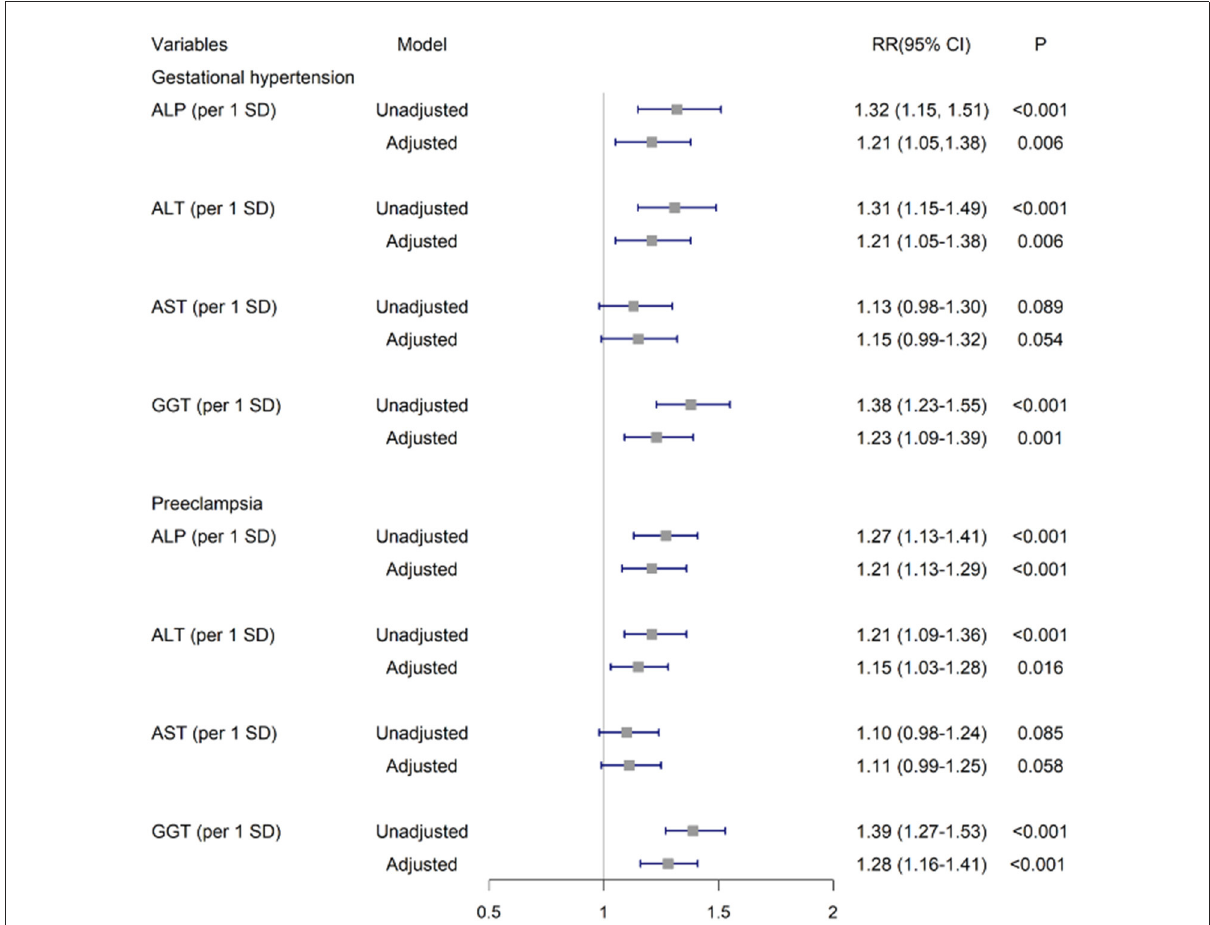
FIGURE2 Associations of ALP, ALT, AST and GGT in early pregnancy with GH and PE. The risk ratios and 95% CIs were estimated by multivariable log-binomial regression adjusting for age (years), preconception-BMI (normal: BMI < 24 kg/m 2 or overweight/obese: BMI ≥ 24 kg/m 2 ), supplementation of folic acid before pregnancy (yes/no), smoking exposure during gestation (yes/no), whether gravidity > 1 (yes/no), gestational week and fasting glucose at the 1 st antenatal visit. GH, Gestational hypertension; PE, Preeclampsia; GGT, γ -glutamyl transferase; ALT, alanine aminotransferase; ALP, alkaline phosphatase; AST, aspartate